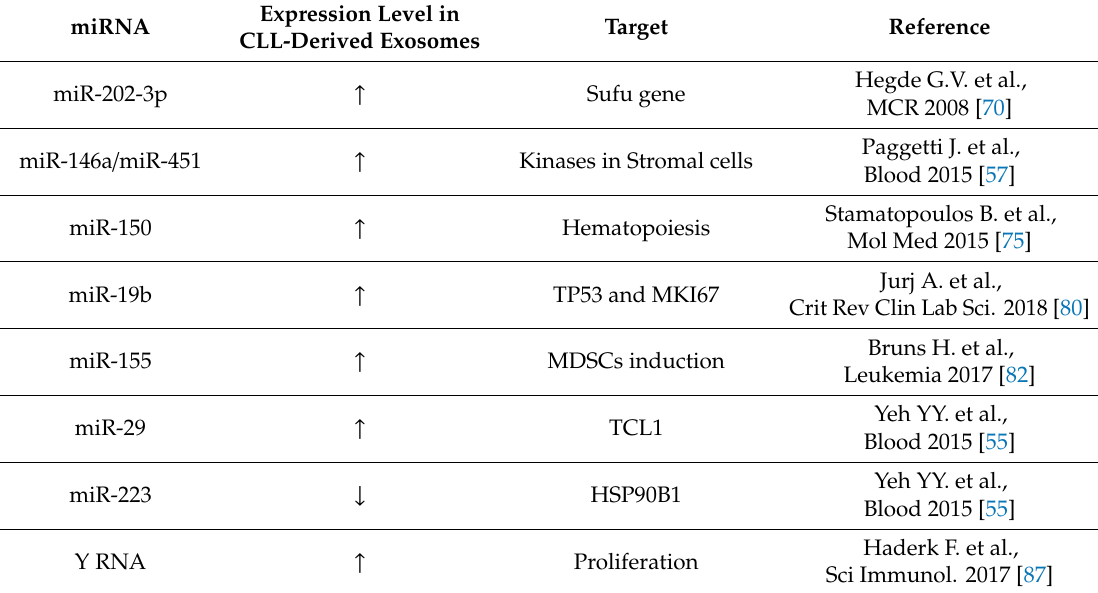
Table 1. Summary of major miRNAs delivered by chronic lymphocytic leukemia (CLL)-derived exosomes. The table shows for each miRNA the expression levels in CLL-derived exosomes respect to normal circulating exosomes (up ↑ or down ↓ ) and the target gene or modulated process. The resulted expression levels of target genes are inversely proportional to expression levels of relative